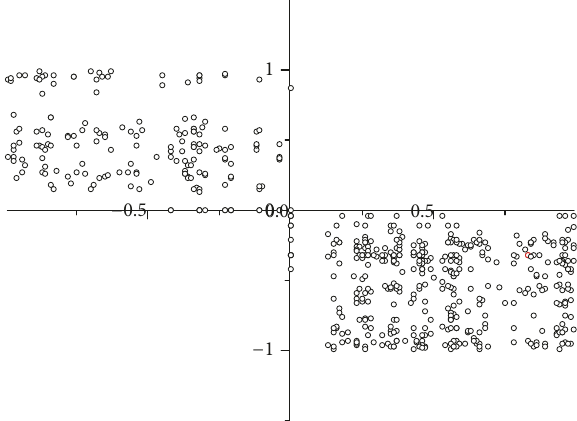
Figure 3: The positive and negative distribution of